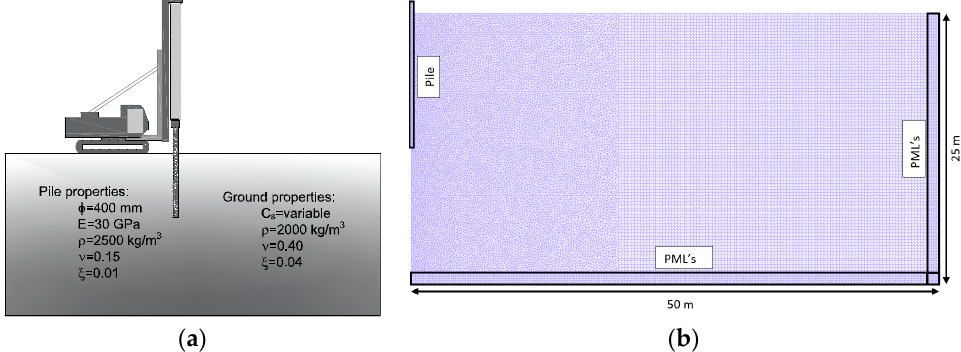
Figure 6. Pile driving in a homogeneous half-space soil: ( a ) application example; ( b ) pile–ground axisymmetric FE–PML mesh.